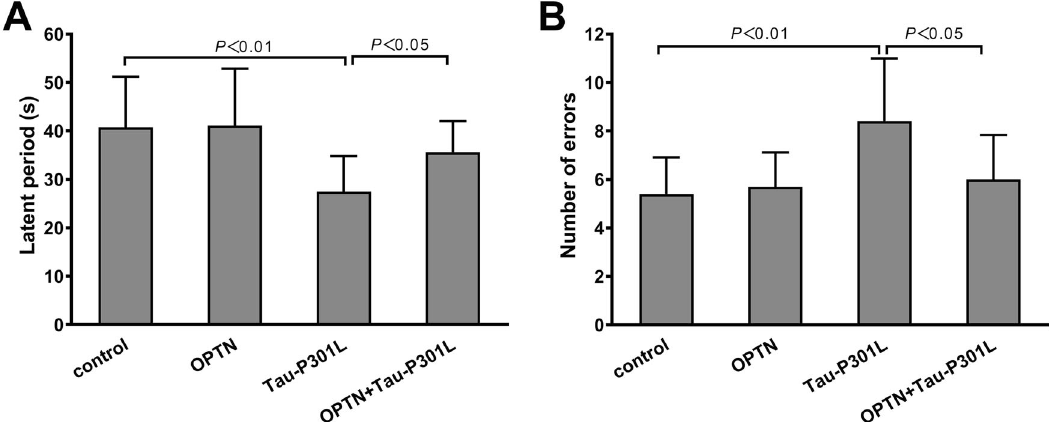
Fig. 4 OPTN redressed the depression of mice in learning and memory (passive avoidance) abilities induced by AAV- MAPT -P301L. A Time of mice fi rst entering the dark chamber (latent period). B Number of mice entering the dark chamber in 5 min (number of errors). The data are shown as means ± SD, n =